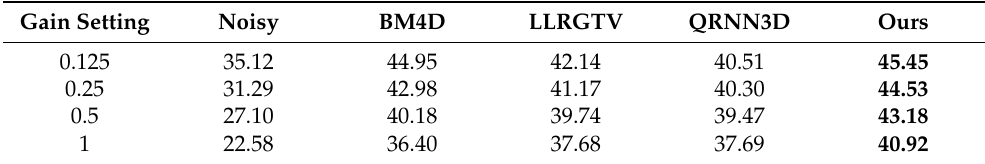
Table 1. Results of the PSNR for the different methods on data with various gain settings (best results are highlighted in bold).